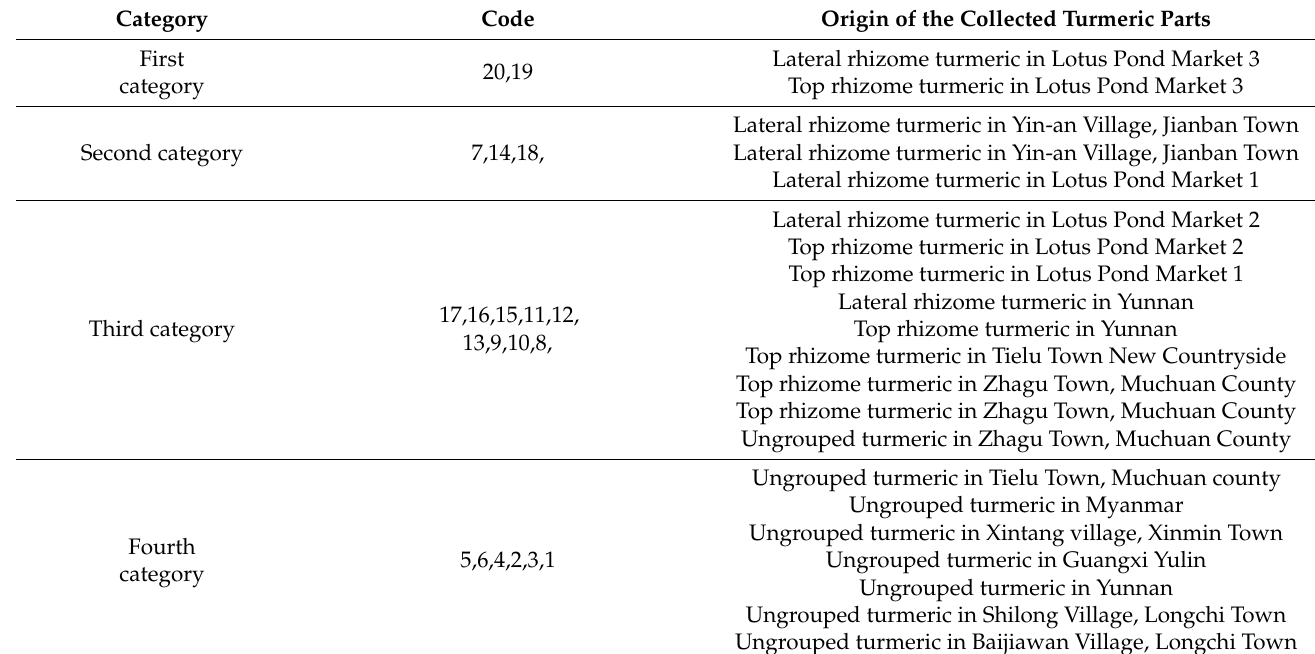
Table 3. Classification table of 20 groups of turmeric samples.